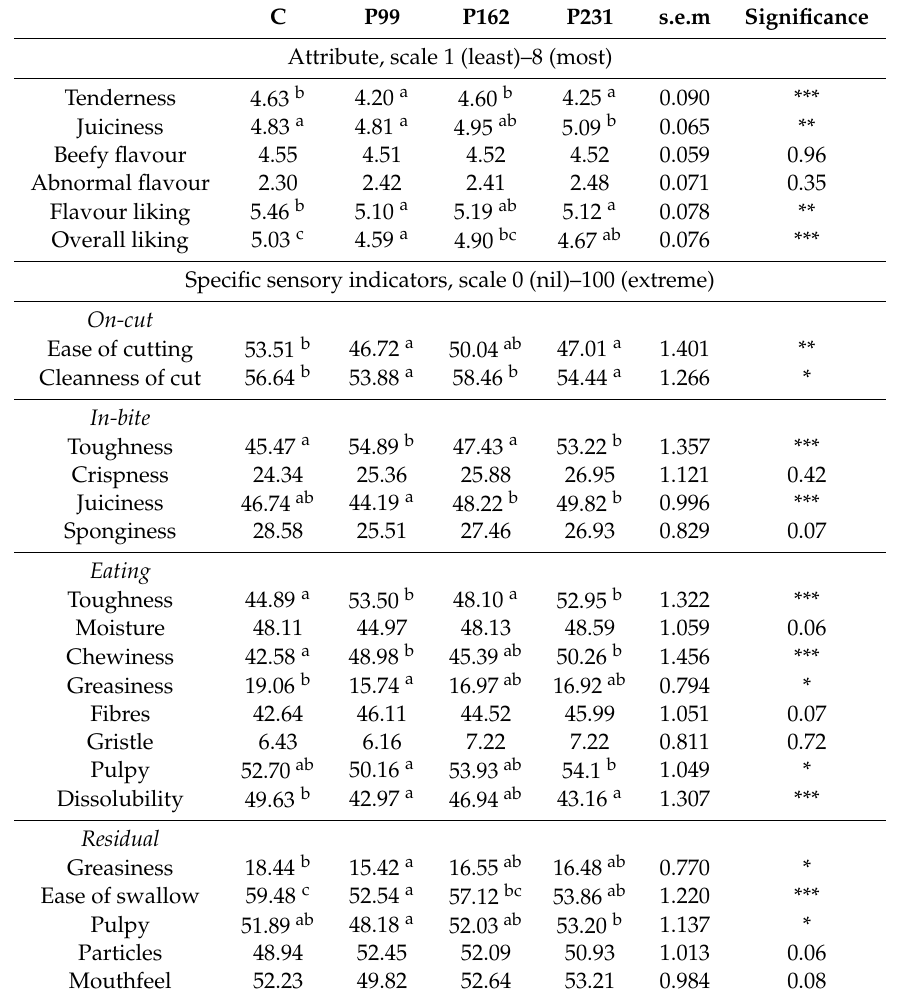
positively correlated ( p < 0.05, at least) with all muscle colour traits except the ‘a’ value. Both slaughter weight and carcass weight were positively correlated ( p < 0.05, at least) with temperature at 48 h post-mortem and with muscle ‘a’, ‘b’ and chroma / saturation values. Carcass conformation score was positively correlated ( p < 0.05, at least) with muscle ‘a’, ‘b’ and chroma / saturation values and negatively correlated ( p < 0.05) with subcutaneous fat ‘L’ value, IMF and collagen cross link concentrations. Carcass fat score was positively correlated ( p < 0.05) with subcutaneous fat ‘a’, ‘b’ and chroma / saturation values, with the proportion of muscle fibre type IIA and tended ( p < 0.10) to be positively correlated with IMF concentration. Carcass fat score was negatively correlated ( p < 0.05) with subcutaneous